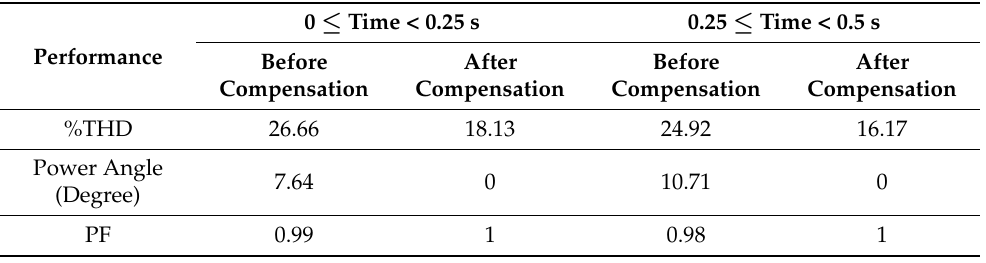
Table 5. The average performance value of ADALINE individual harmonic detection.